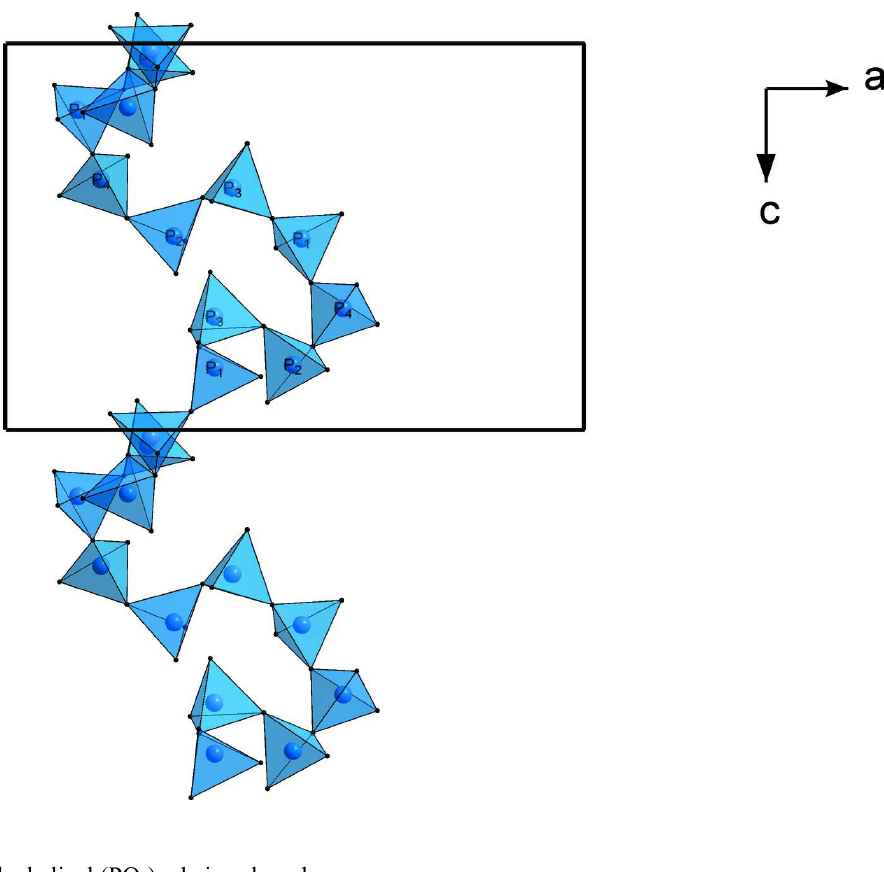
) chains along b. 3 n